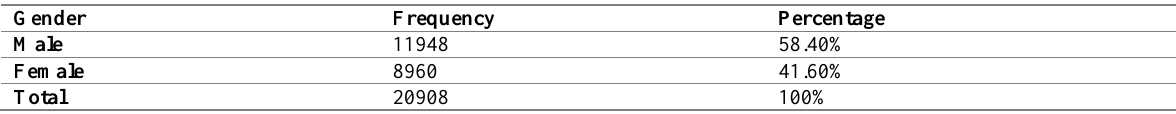
Table 3: Gender Distribution